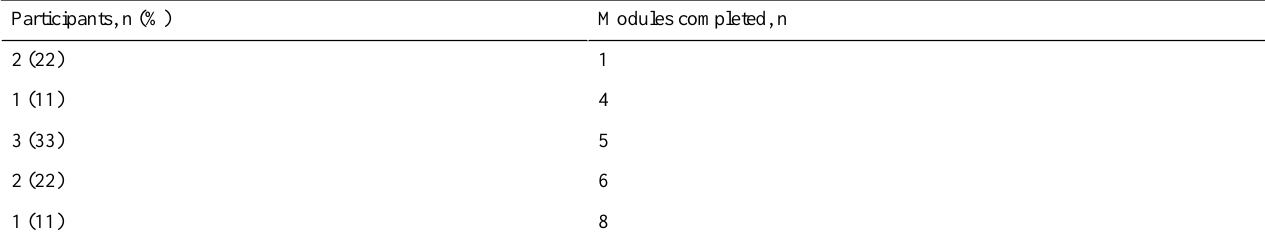
Table 2. Number of modules completed